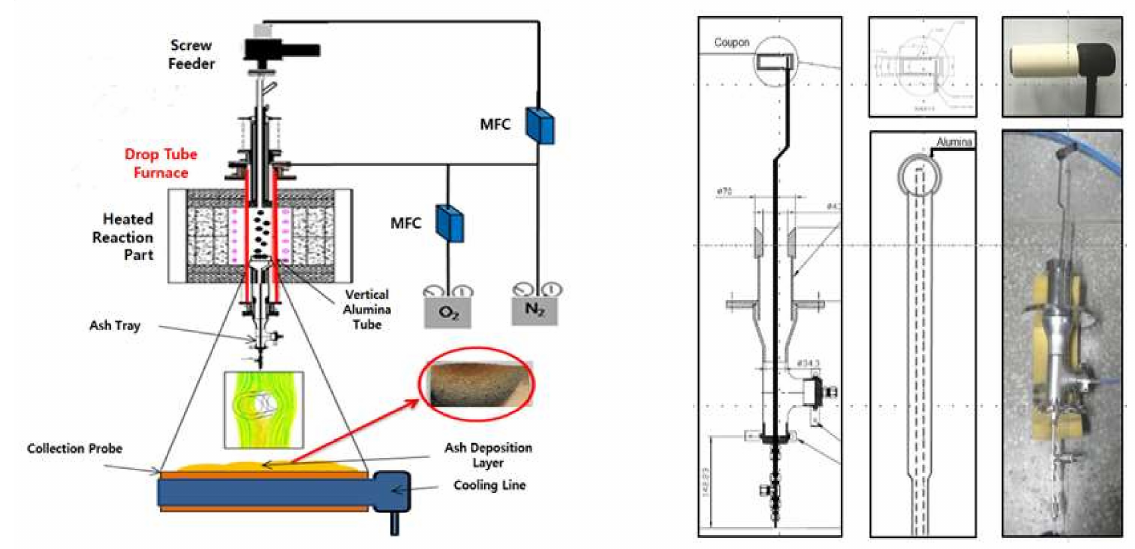
Figure 5. Schematic representation of the components of a drop tube furnace (DTF) connected to an ash deposition probe